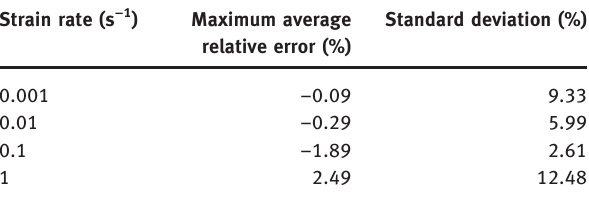
Table 3: Error analysis of predicted ( σ P ) and measured true stress ( σ M